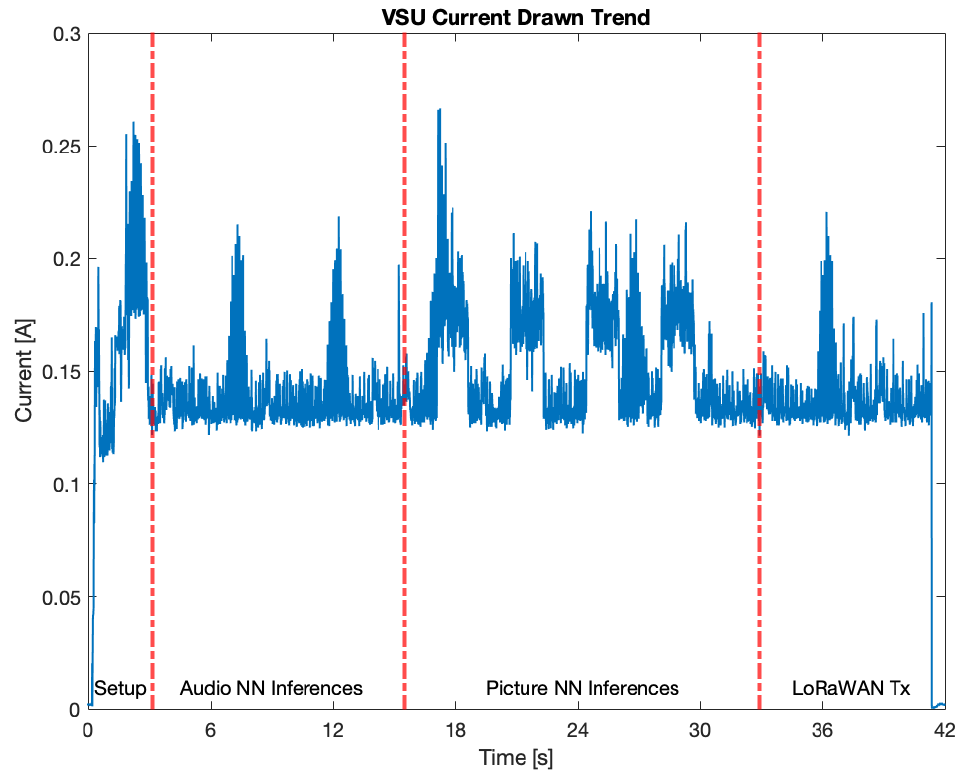
Figure 12. VSU prototype current